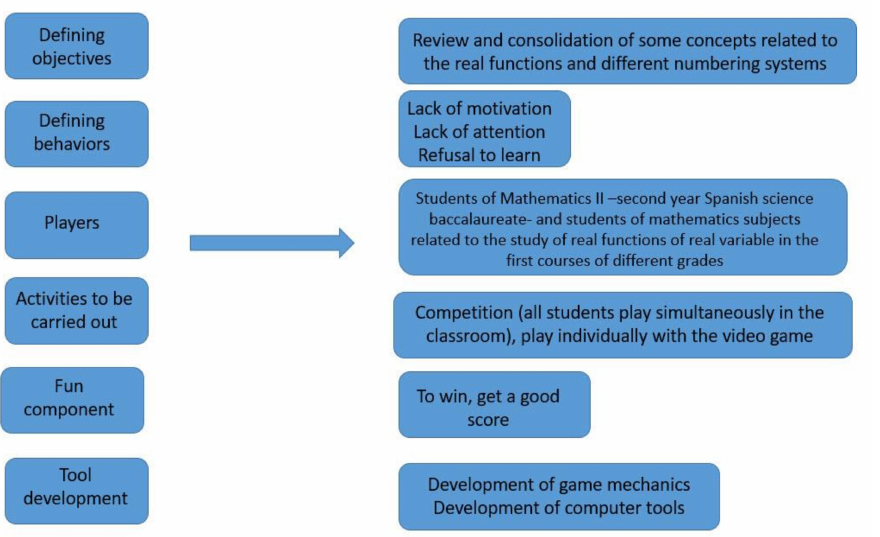
Figure 2. Steps to follow for the implementation of the